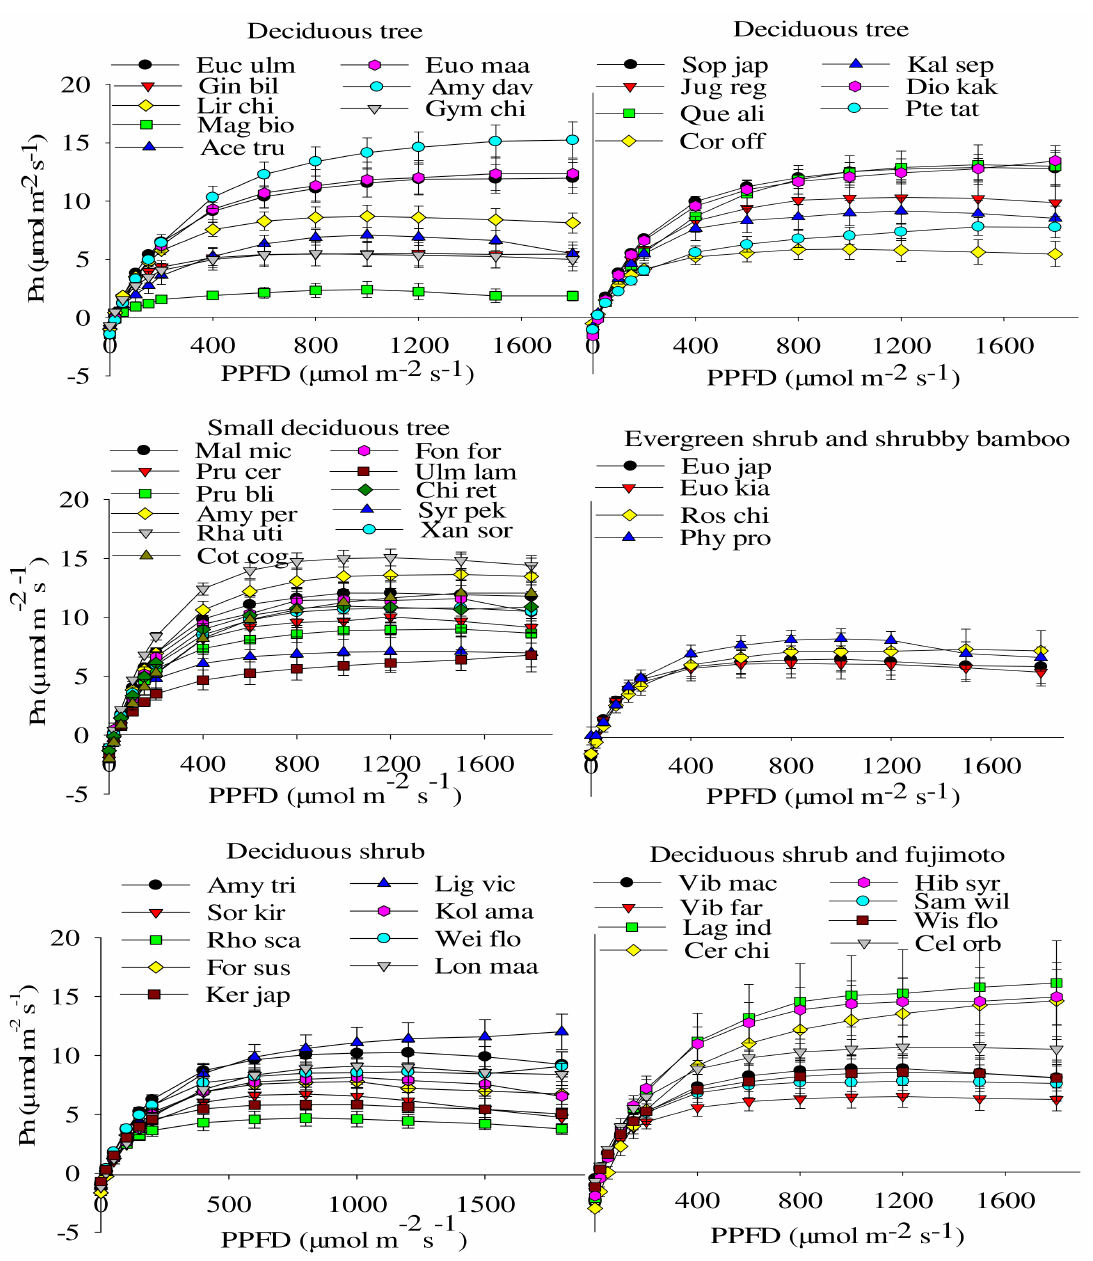
Figure 1. Light photosynthetic response curves (mean ± SE, n = 5) of forty-seven woody species. Pn and PPFD are net photosynthetic rate and photosynthetic photon flux density, respectively. Species abbreviations are shown in Table 1. Table 1. Forty-seven commonly used species in green spaces in North